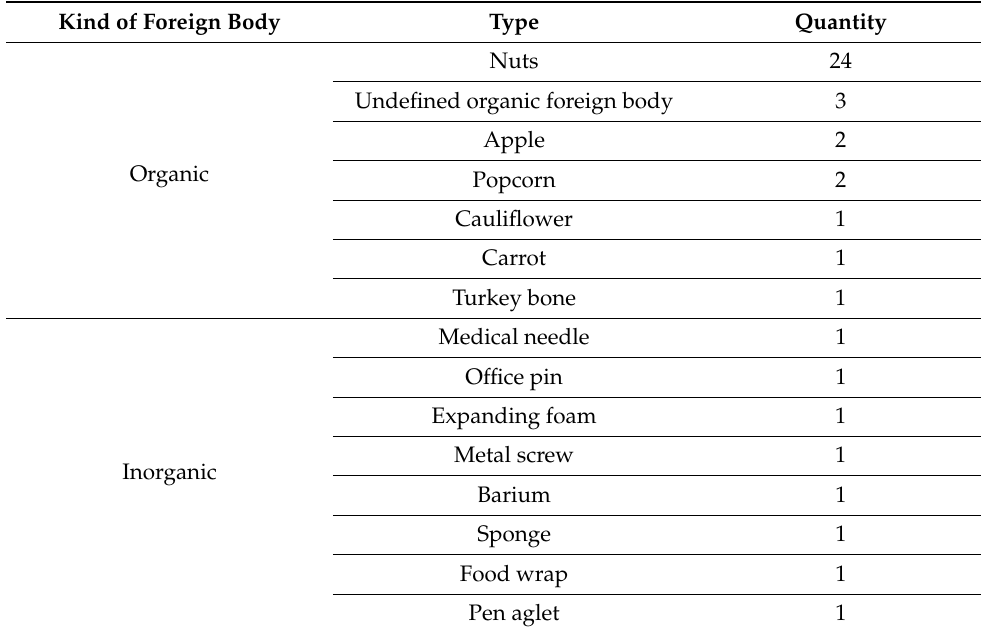
Table 1. Kind and quantity of foreign bodies aspirated to lower